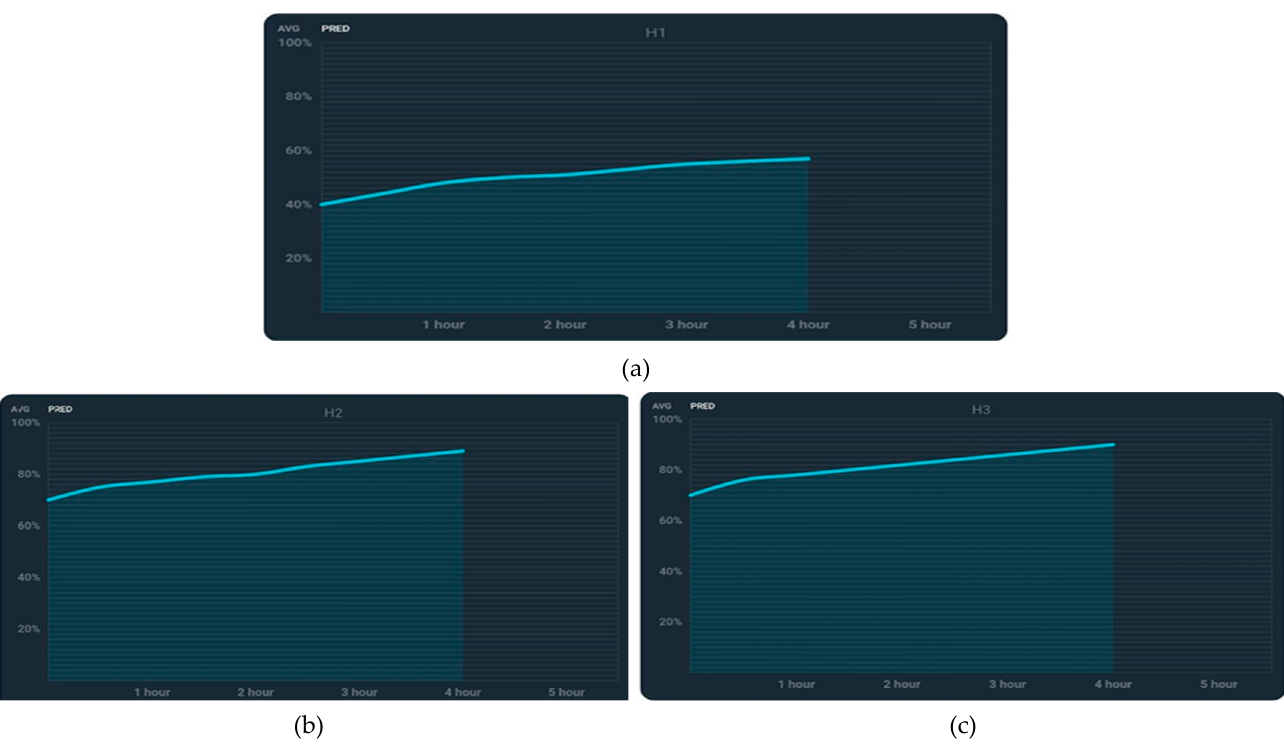
Figure 11. Humidity measurements; ( a ) from location A1, ( b ) from location A2, and ( c ) from location A3.